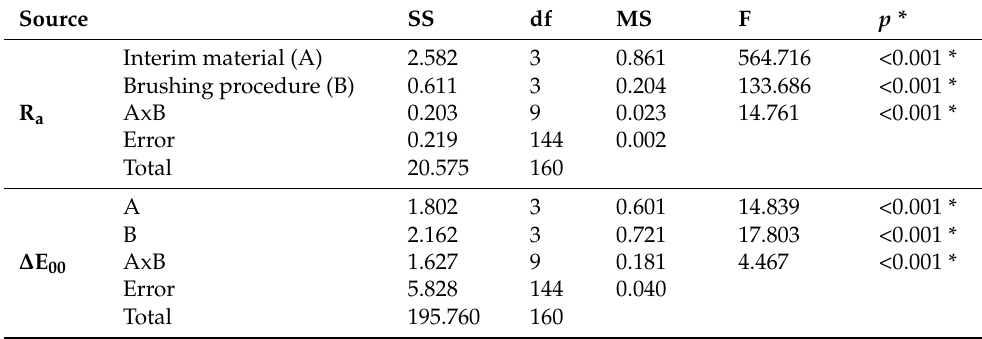
Table 2. Two-way ANOVA results for R a and ∆ E 00 values.